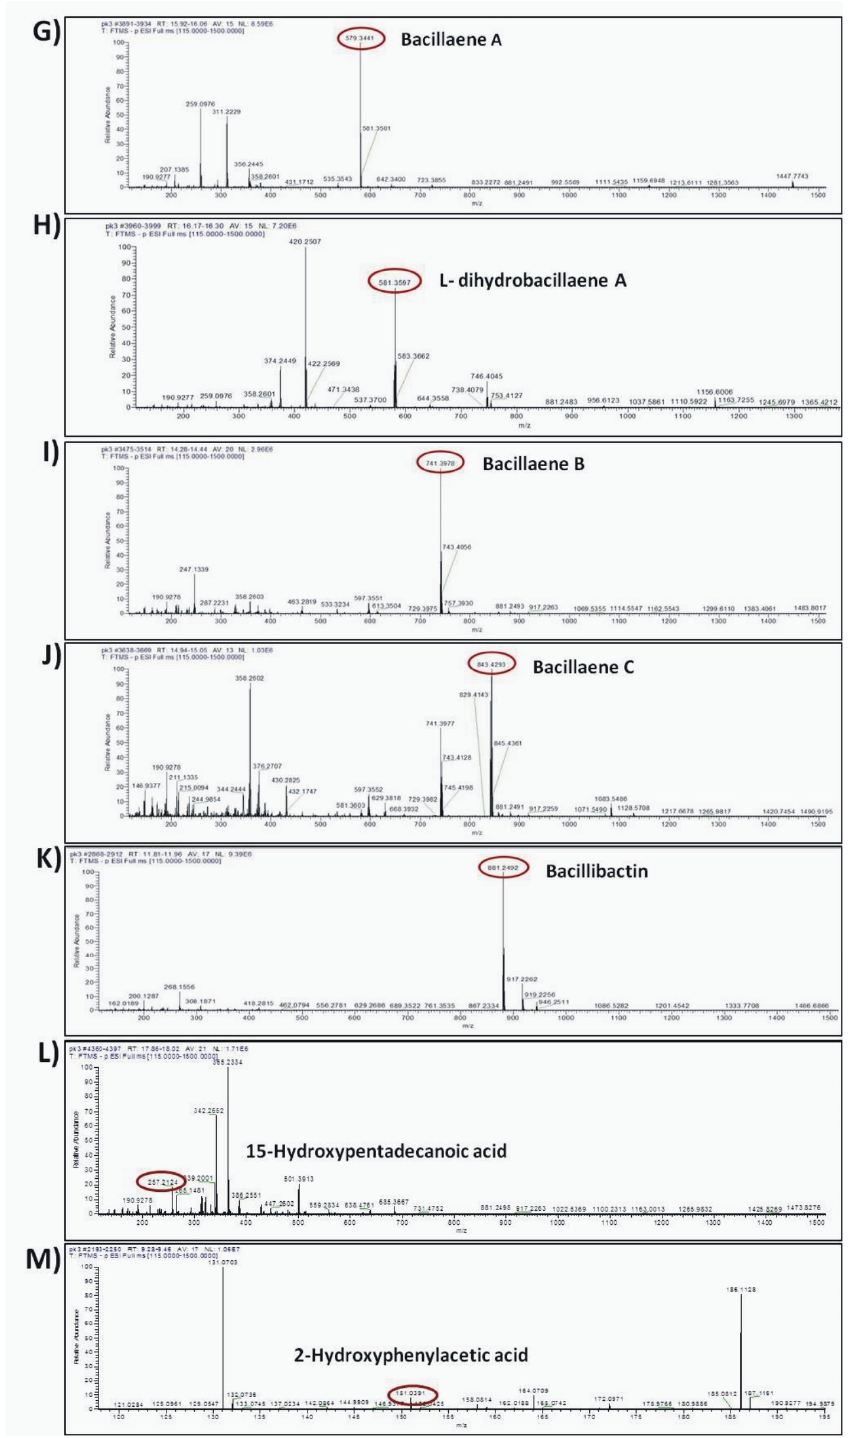
Figure 8. Agar-diffusible secondary metabolites secreted by B. halotolerans Cal.l.30 and annotated through UHPLC-HRMS analysis. The compounds were putatively annotated based on isotope distribution and the accurate mass ( ± 5 ppm). The precise masses revealed the presence of compounds ( A ) mojavensin A, ( B ) fengycin A, ( C ) Surfactin A C 13, ( D ) Surfactin A C 15 , ( E ) L-dihydroanticapsin ( K ) bacillibactin, ( G – J ) four analogues of bacillaene, known as bacillaene A, dihydrobacillaene, bacillaene B and bacillaene C, respectively, ( F , L , M ) azelaic acid, 15-hydroxypentadecanoid acid and 2-hydroxyphenylacetic acid,